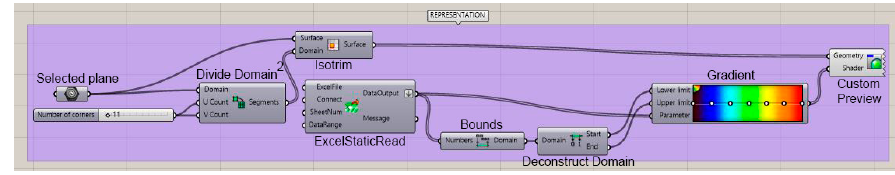
Figure 12. Algorithm designed to graph the results.